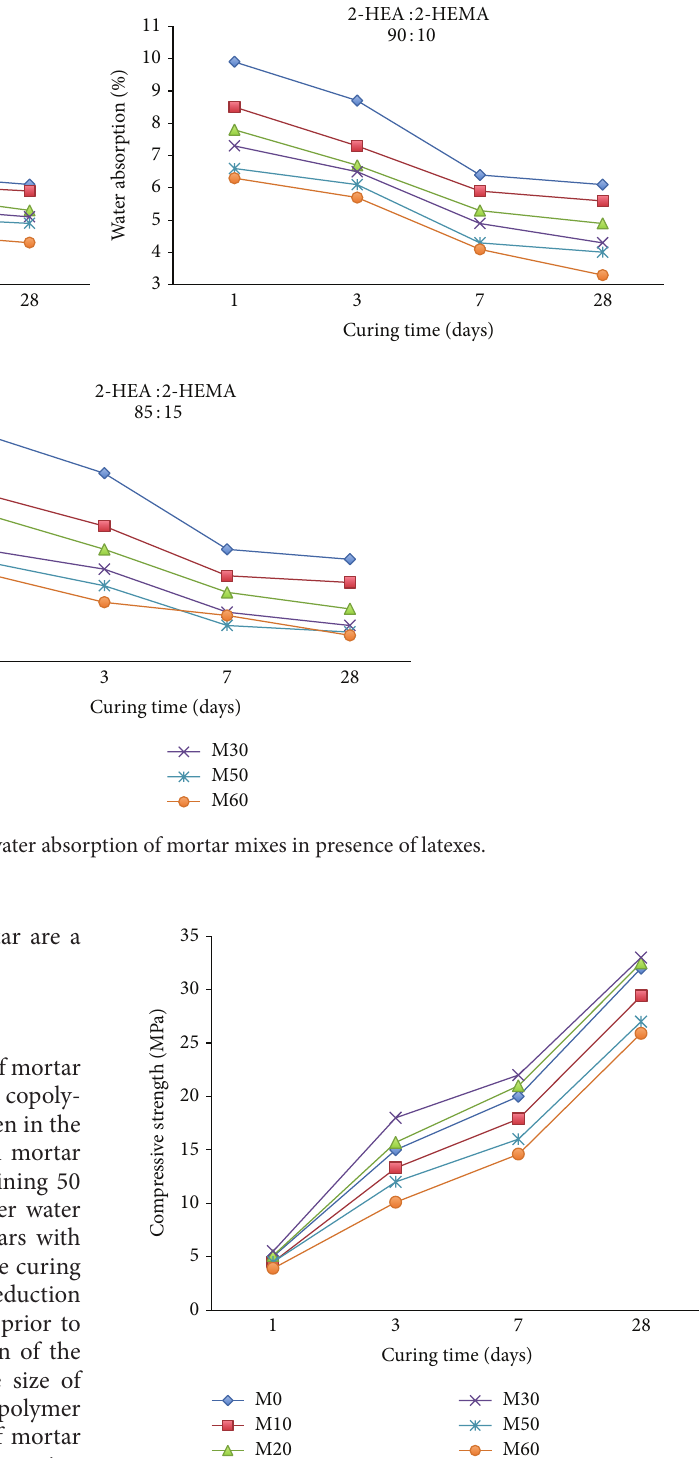
Figure 7: The effect of FA on compressive strength of mortar mixes without